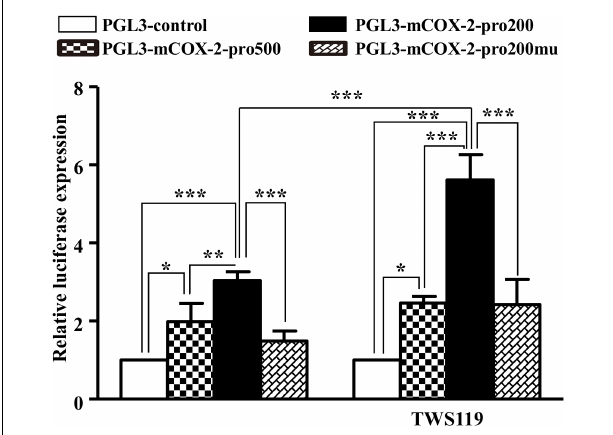
FIGURE 9 | β -Catenin regulated promoter activity of COX-2. The promoter activity of COX-2 was measured by the luciferase reporter assay. The core promoter region containing β -catenin binding site or the mutant site which could not bind by β -catenin was cloned into luciferase reporter vector. After transfection into HEK293T cells, luciferase activities were measured with or without TWS119 addition; ∗ P < 0.05, ∗∗ P < 0.01, ∗∗∗ P < 0.001.